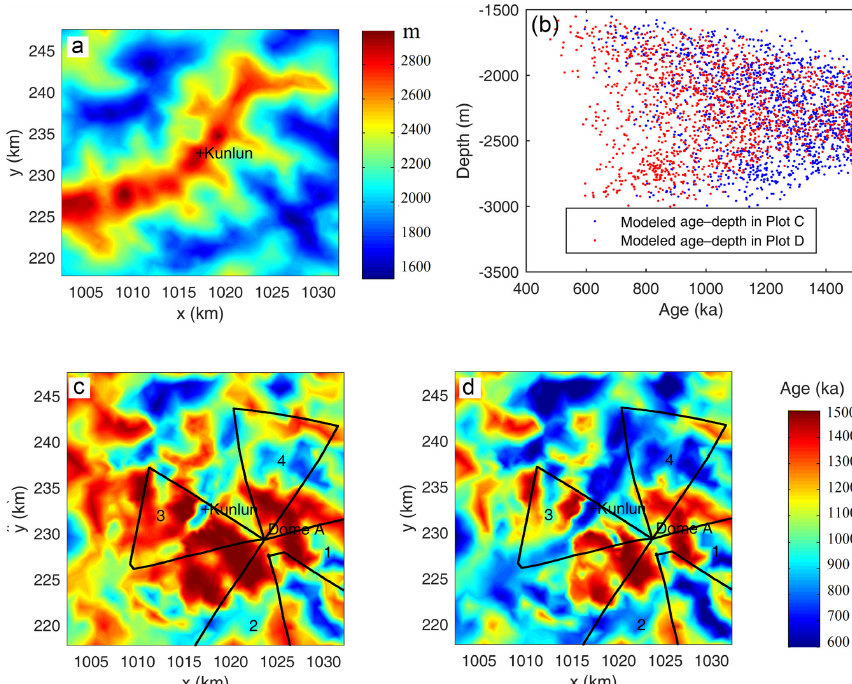
Figure 5. 95% depth in the central 30 × 30km 2 model domain (a) and modeled age of the ice at this depth using Kunlun fabric and a geothermal heat flux of 55 ( c , blue dots in b ) and 60 ( d , red dots in b )mWm − 2 and surface temperature of − 58.5 ◦ C. The areas with no basal melt are arbitrarily limited to an age of 1.5Ma. The black cross is Kunlun station. The black line marks the polarimetric radar survey route triangles marked in Fig. 4.